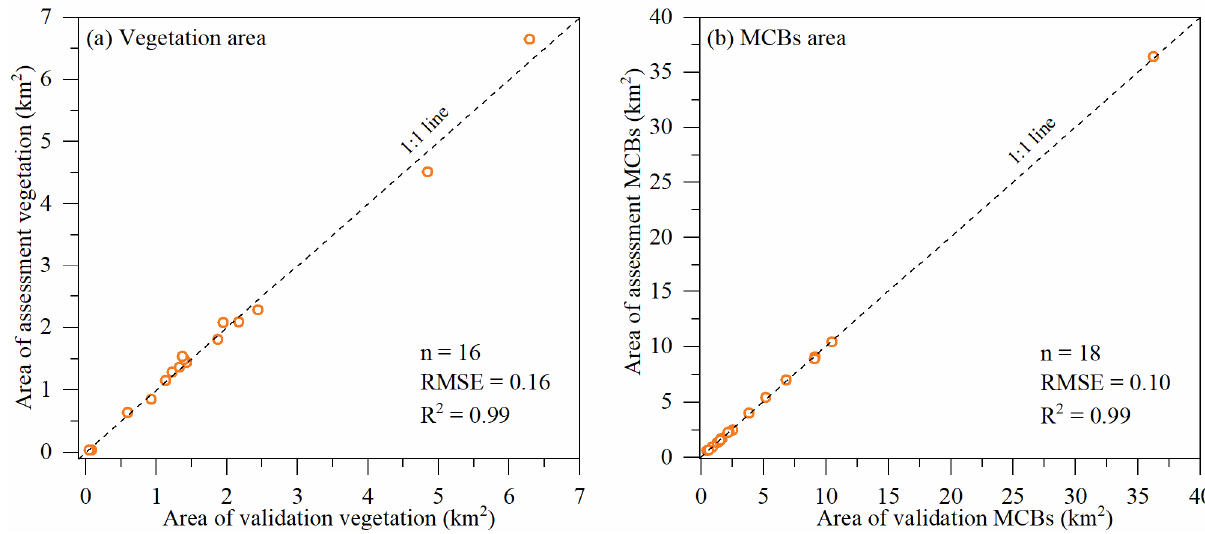
Figure 3. Accuracy assessment of extracted MCB vegetation area ( a ) and MCB area ( b ).